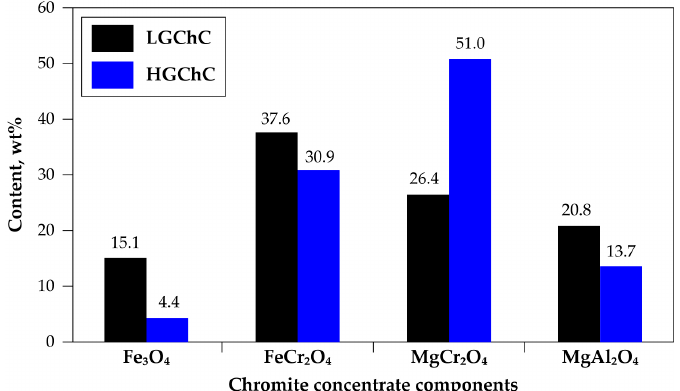
Figure 4. Mineralogical composition of the chromite concentrate samples.